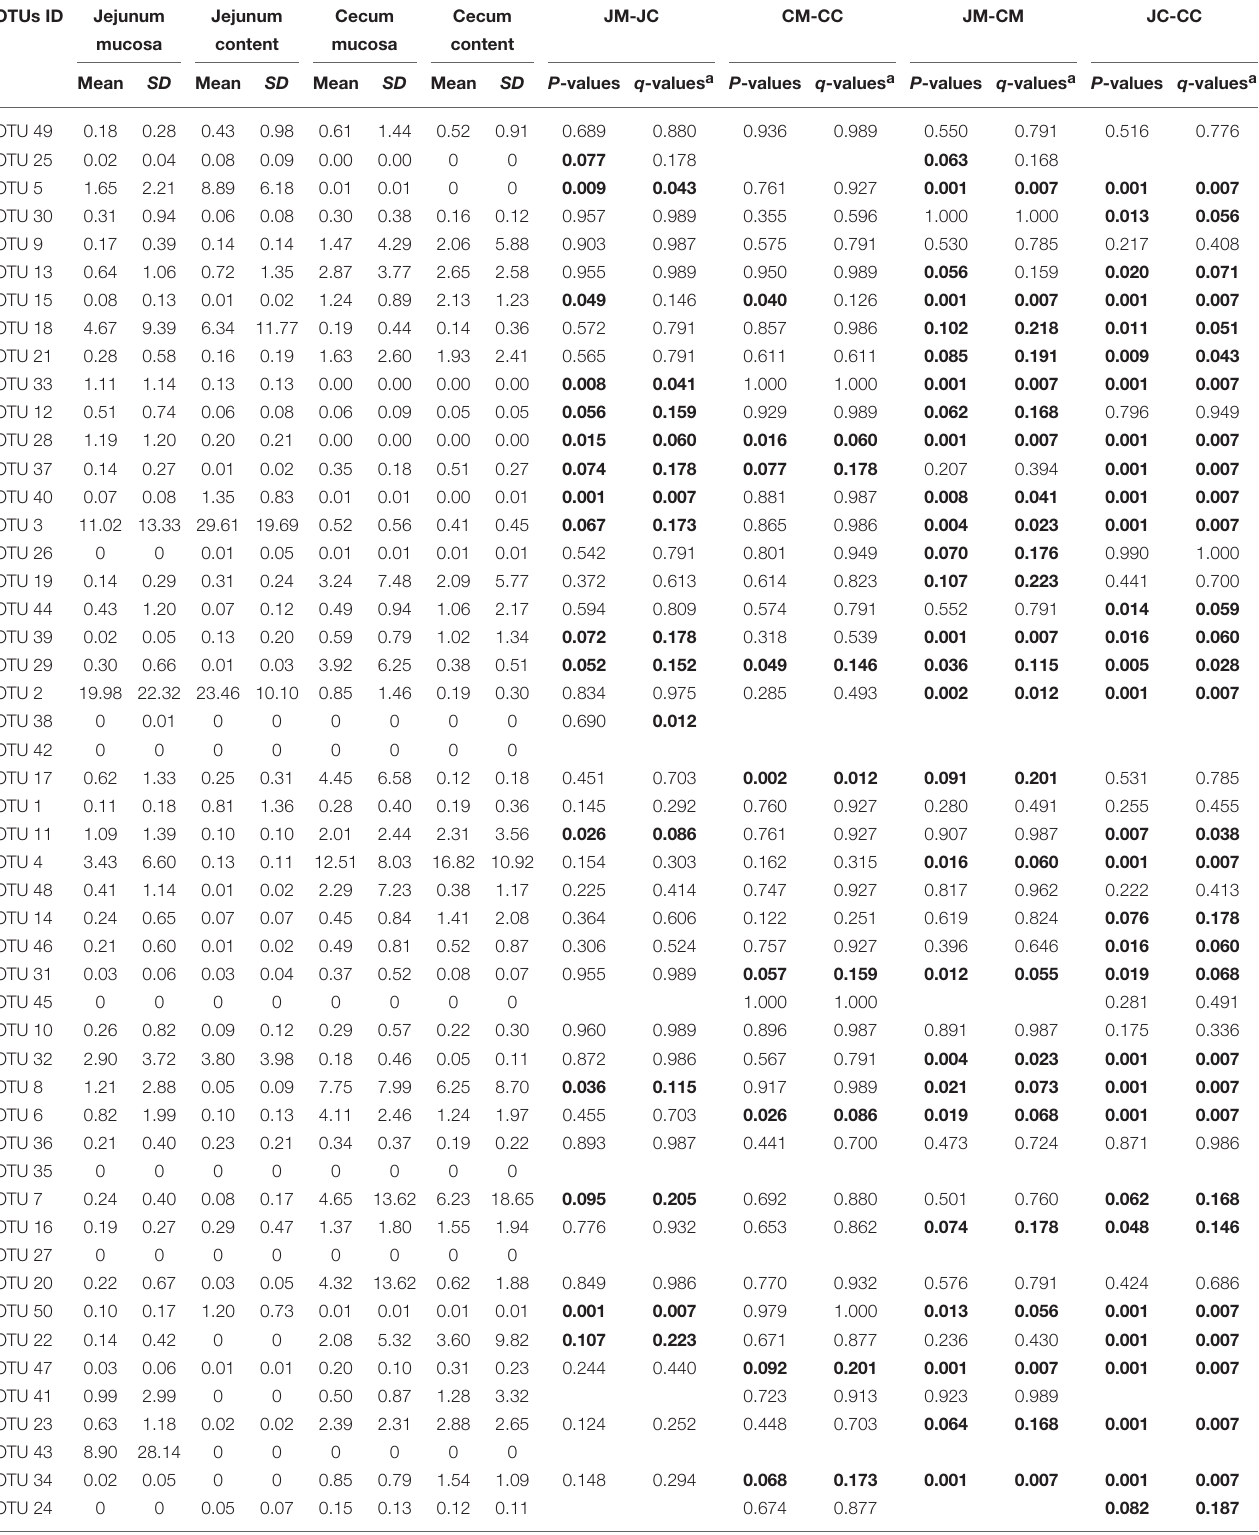
TABLE 3 | Relative abundances (%) of the most abundant OTUs in different gut sites of infected birds (days 21 and 28). OTUs